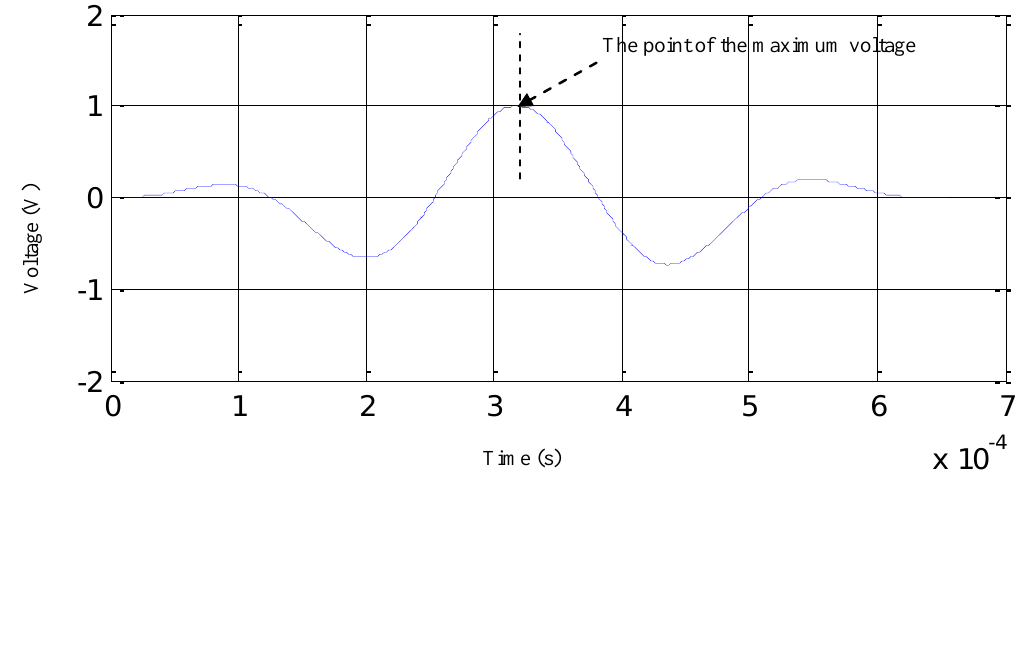
Figure 8. Constructed normalized sinusoidal modulation signal of frequency band of [2,392 Hz, 5,434